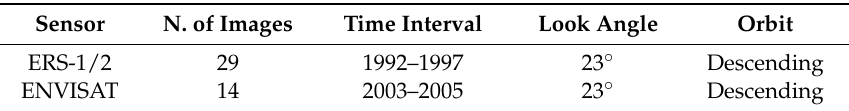
Table 1. Summary of the InSAR